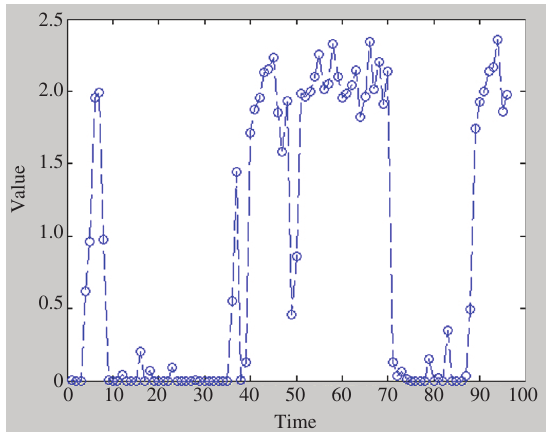
Figure 6. Values of the Network Security Situation in the First 4